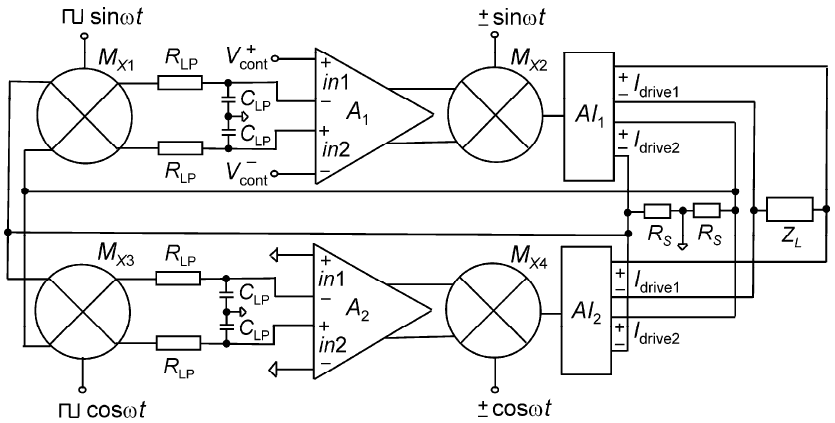
Figure 14. Block diagram of the current driver with its corresponding phase compensation. The upper part represents the current driver, where the lower part is the compensation with zero control voltage and cos ω t (Reproduced from [25], with permission from the IEEE).